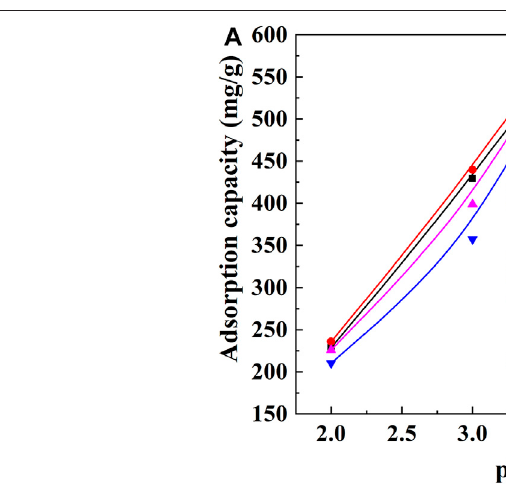
FIGURE 7 | Variable curves of adsorption capacity (A) and removal ef fi ciency (B) against the change of pH